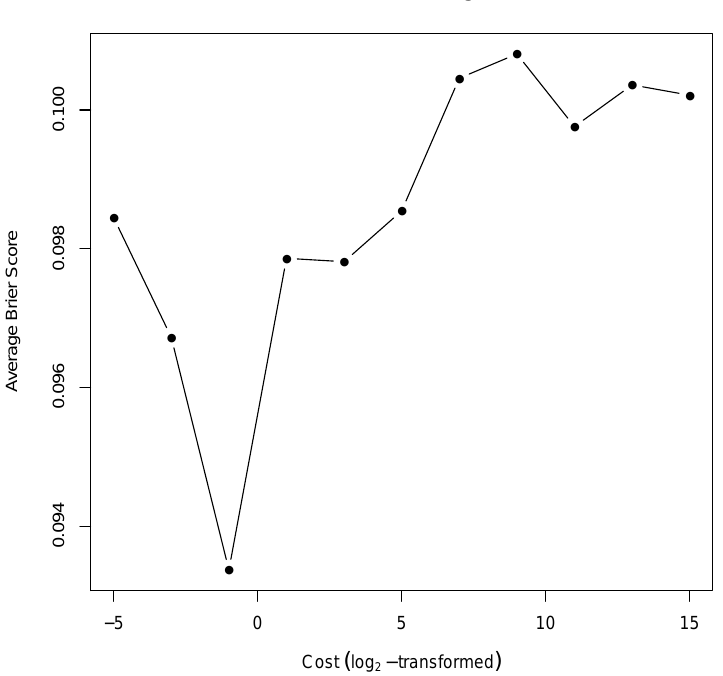
Figure 7. The performance profile of the support vector for predicting the statement mutation